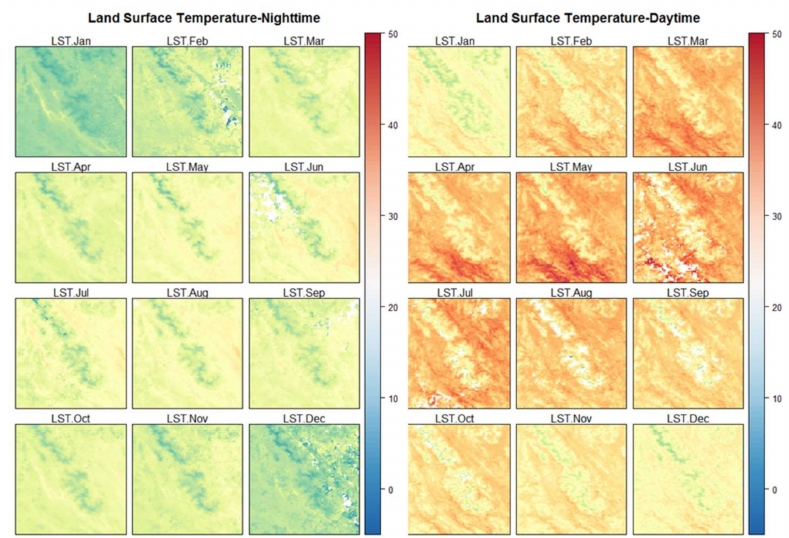
Figure 2. The spatial patterns of the monthly average nighttime ( left ) and daytime ( right ) land surface temperature (LST) in 2015 in northwest Vietnam.